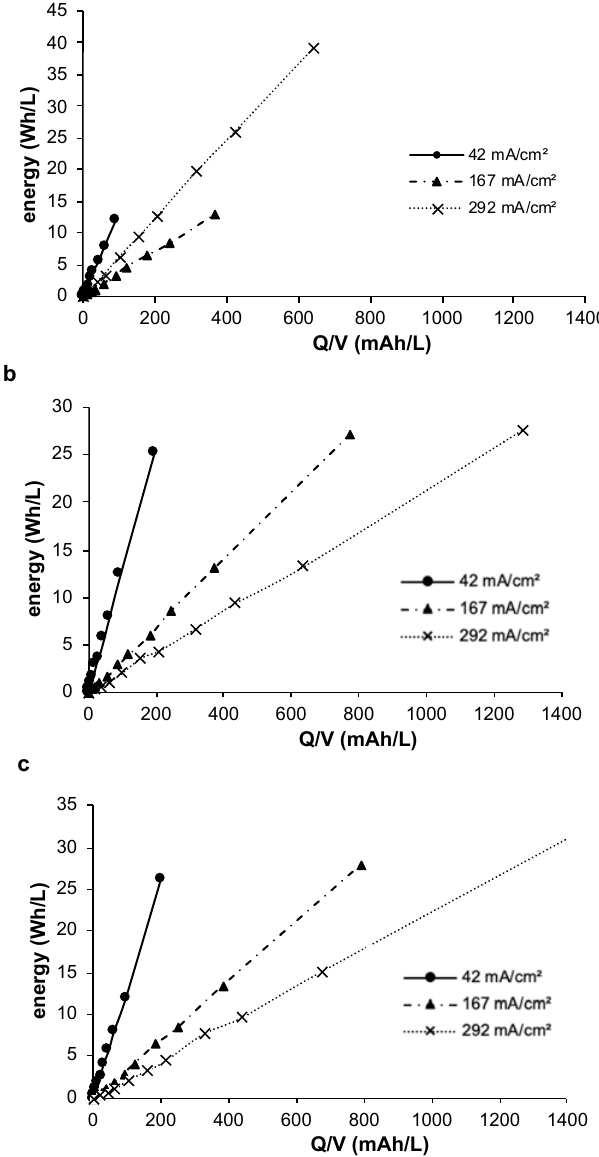
Figure 5. Energy demand for oxidation of DCF using different current densities in deionized water ( a ), drinking water ( b ) and wastewater effluent ( c ).